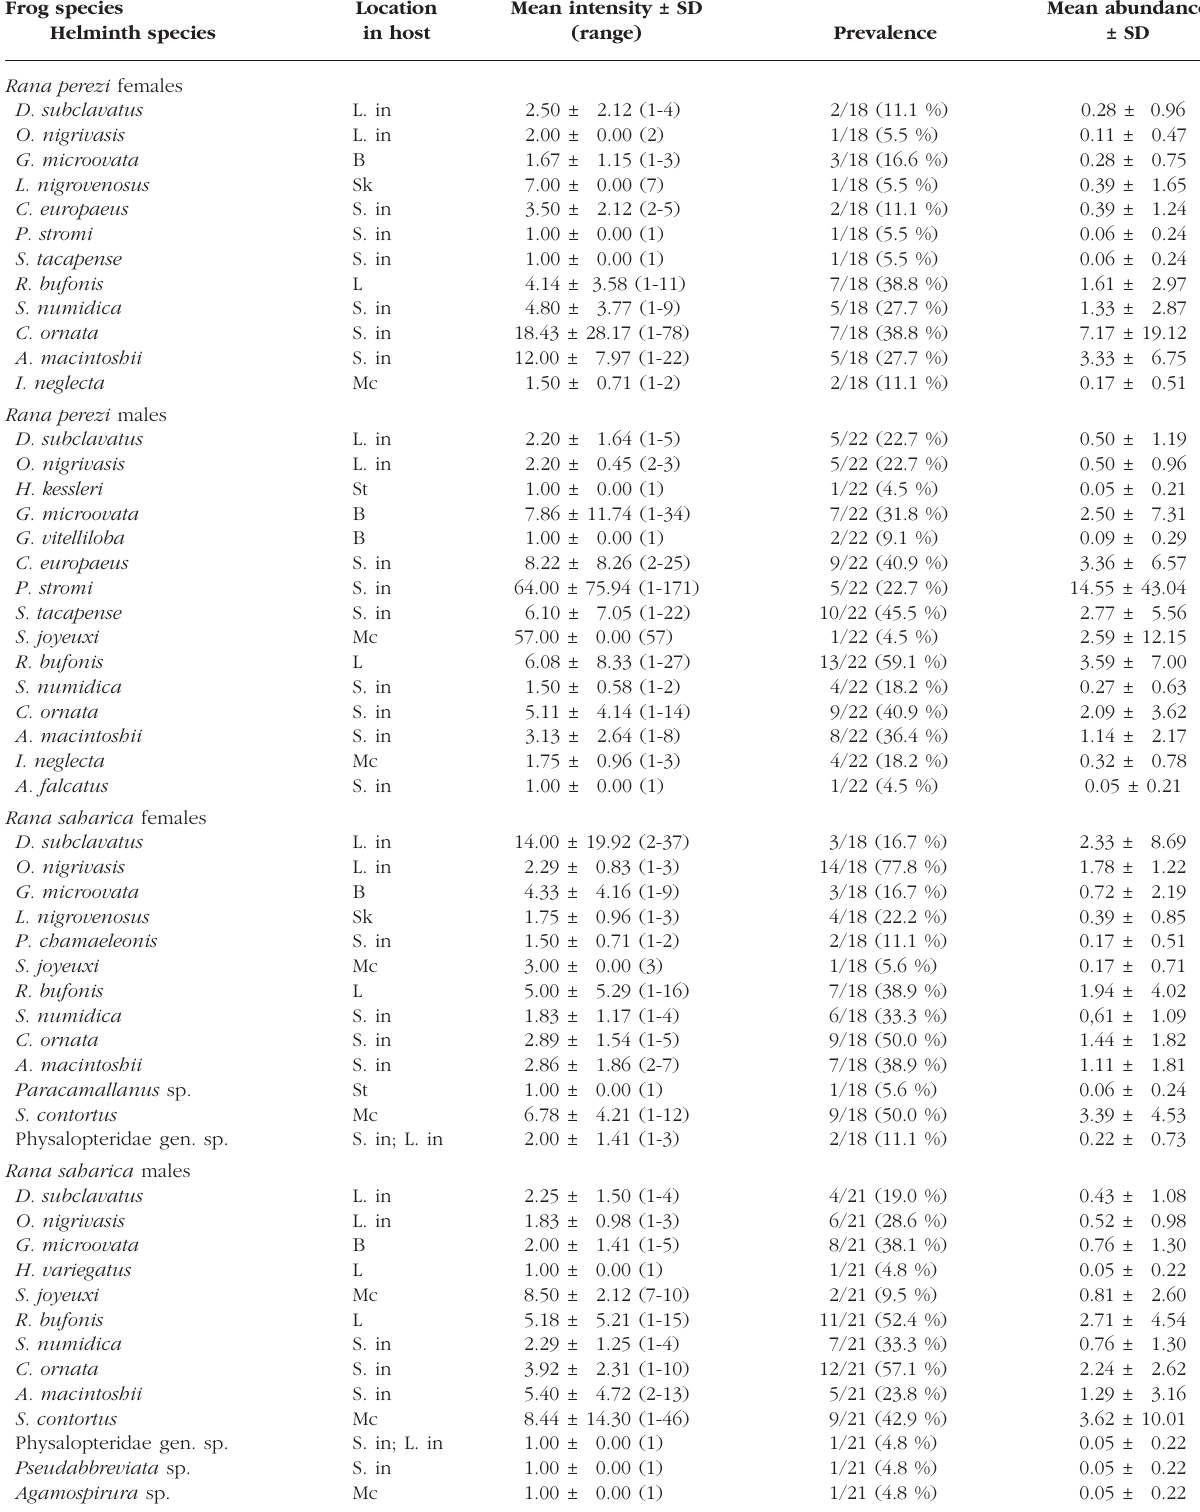
Table I. – Location, mean intensity, prevalence and mean abundance of helminth parasites recovered from males and females of Rana perezi and Rana saharica (L. in = large intestine; B = bladder; Sk = skin; S. in = small intestine; L = lungs; Mc = muscles; St =